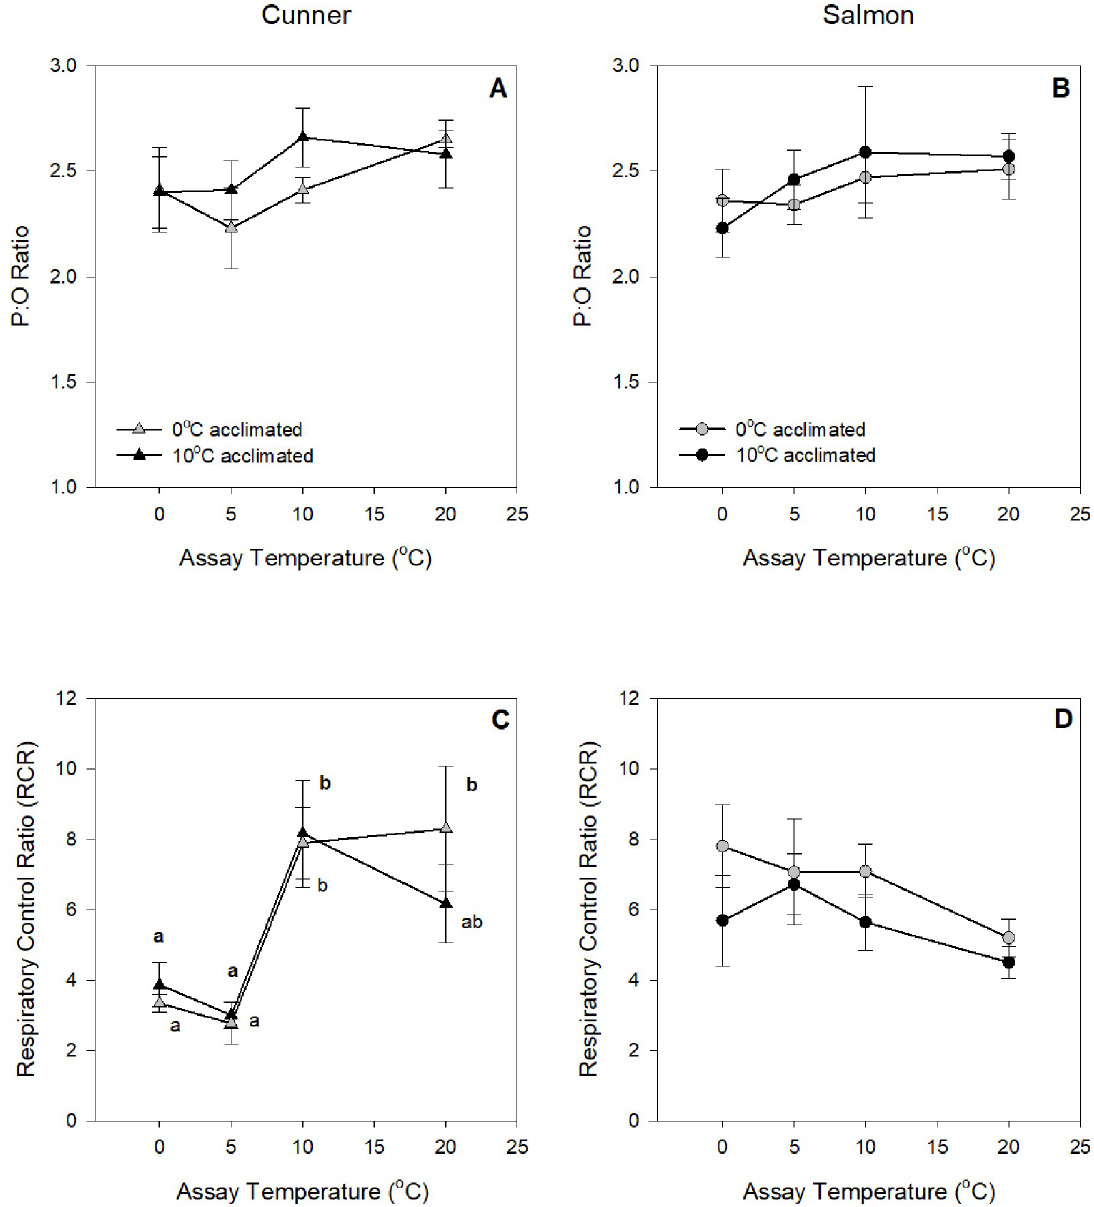
Fig 2. P:O ratio (A, B) and respiratory control ratio (RCR; C, D) values for isolated liver mitochondria from 0 and 10˚C acclimated cunner (A, C) and salmon (B, D), measured at 0˚C, 5˚C, 10˚C and 20˚C. Letters indicate significant differences within a species amongst assay temperatures, whereas an asterisk ( � ) indicates a significant difference between species at a particular assay temperature (P < 0.05). There were no significant acclimation effects or significant differences between species at a particular assay temperature; as determined by a 3-way repeated measures ANOVA, followed by 2-way ANOVAs and Newman-Keuls post-hoc tests. Values without a letter in common are significantly different within a species between assay temperatures. Q 10 values and letters in bold refer to the 10˚C acclimated groups. Values are means ± s.e.m., N =